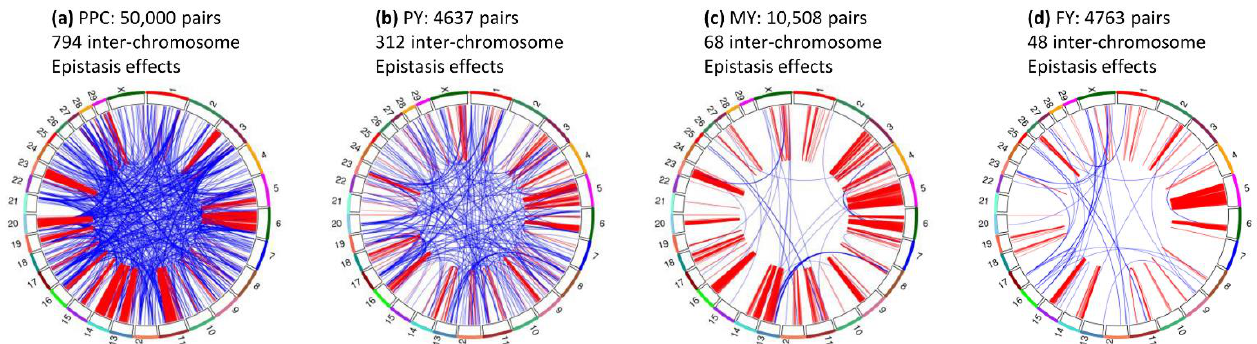
Figure 9. Inter-chromosome epistasis effects with log10(1/p) ≥ 12 for protein percentage and three yield traits. Each number on the outer circle is the chromosome number, red color represents intra-chromosome epistasis effects, and blue color represents inter-chromosome epistasis effects. PPC = protein percentage. PY = protein yield. MY = milk yield. FY = fat yield. ( a ): Intra- and inter-chromosome epistasis effects of protein percentage. ( b ): Intra- and inter-chromosome epistasis effects of protein yield. ( c ): Intra- and inter-chromosome epistasis effects of milk yield. ( d ): Intra- and inter-chromosome epistasis effects of fat yield.